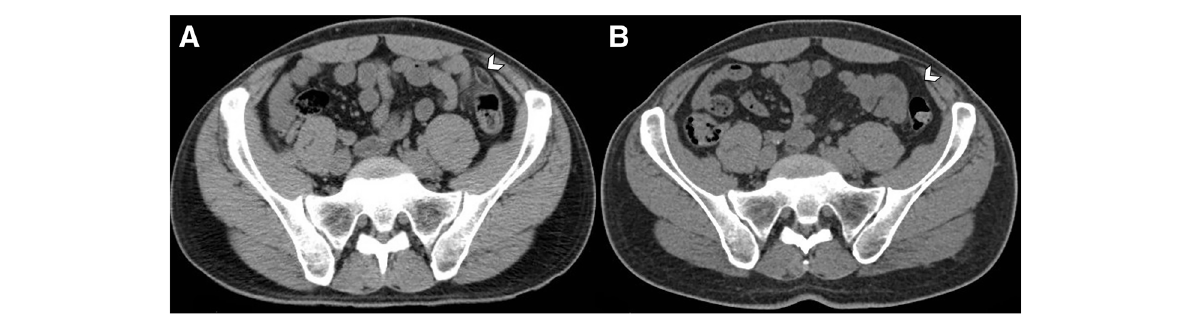
Fig. 7 Evolution of acute epiploic appendagitis in a 37-year-old man. a Axial non-contrast CT image shows an inflamed fatty ovoid lesion near the sigmoid colon (arrowhead), with hyperattenuating ring sign and nearby fat stranding. b CT scan, performed 1 year later for other reasons, demonstrates complete resolution of imaging findings of epiploic appendagitis